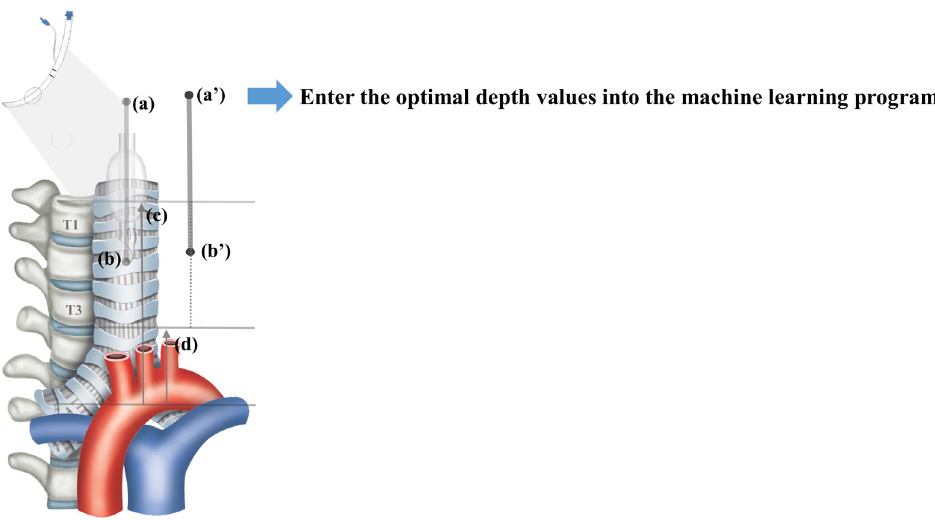
Fig 1. Method of estimating the optimal depth of the tracheal tube. Step 1 . From the electronic medical record, retrieve the recorded depth of the tracheal tube (a). Step 2 . Measure the distance from the carina to the tracheal tube tip (b) on the chest X-ray. Step 3 . Assume that the median of the distance from the carina to the upper margin of T1 (c) and the distance from the carina to the lower margin of T3 (d) is the optimal tracheal tube tip position (b’). Step 4 . The optimal tube depth (a’) is determined by moving the tube from the previous tube depth (a) to the difference between the tracheal tube tip (b) and the optimal tracheal tube tip (b’). Step 5 . Enter the optimal depth values (a’) into the machine learning